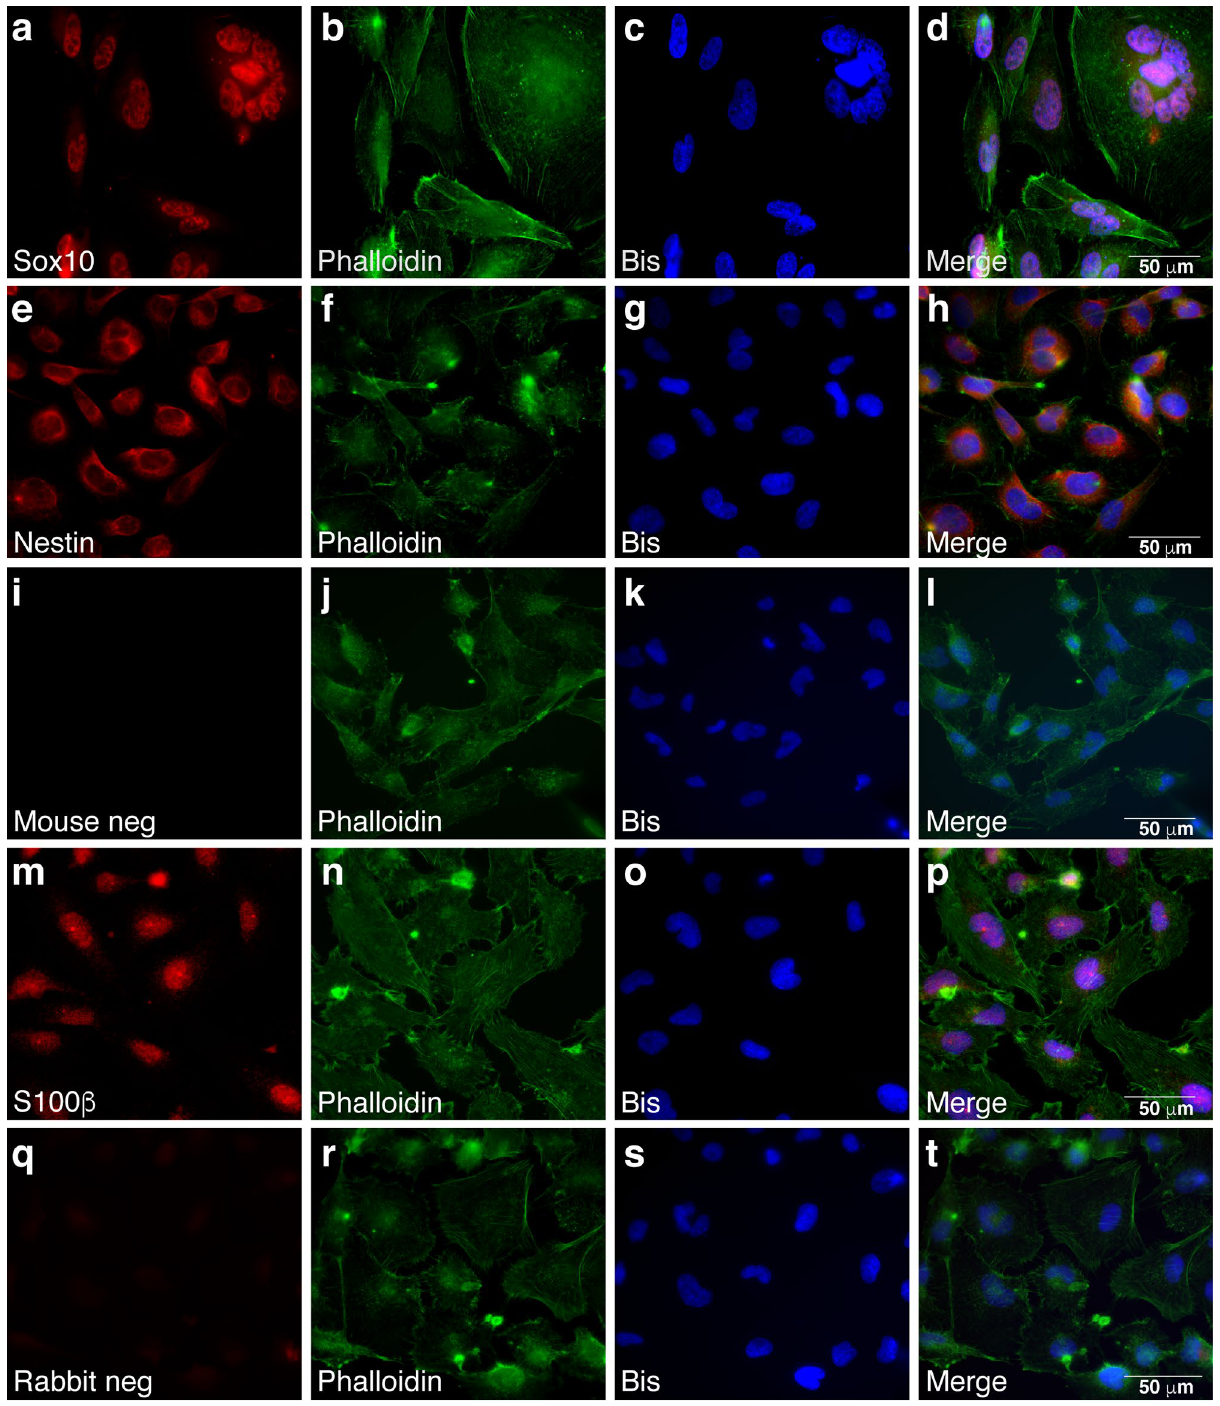
Figure 3. The immunoreactivity of the 2XSB sporadic MPNST cell line recapitulates the pattern seen in the parent tumor. ( a–h , m–p ) Representative immunofluorescence images showing Sox10 (a-d; red), nestin ( e – h ; red) and S100β ( m – p ; red) immunoreactivity in 2XSB cells. ( i – l , q – t) Representative negative control images from preparations in which the primary antibody was replaced with non-immune mouse IgG or rabbit IgG are presented in ( i – l ) and ( q – t ), respectively. To highlight the morphology of these cells, preparations were simultaneously stained with the actin-binding lectin phalloidin (green channel). Bisbenzimide was used as a nuclear counterstain (blue